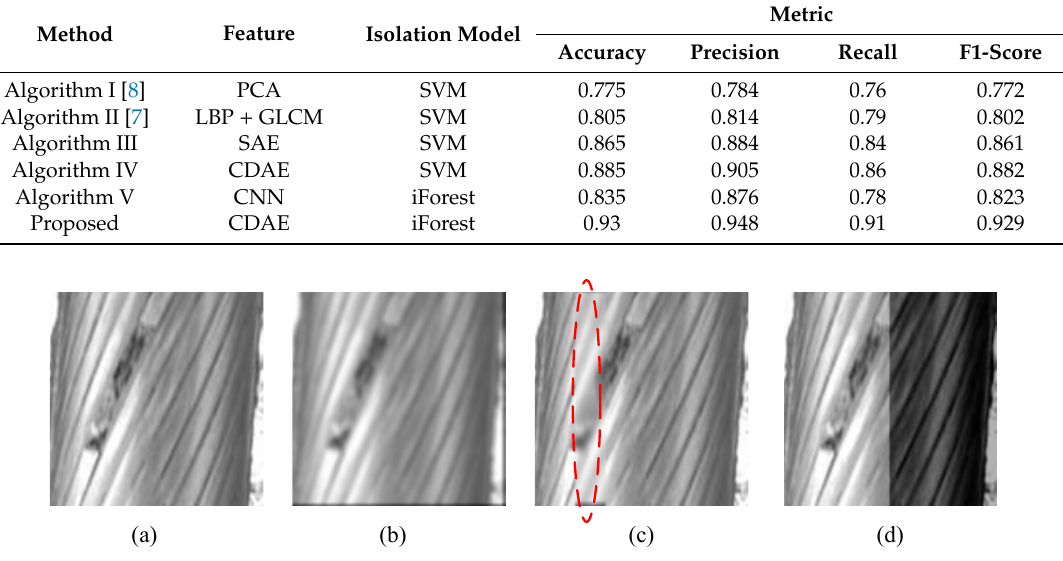
Figure 5. Flaw image augmentation. ( a ) Source images; ( b – d ) Image augmentation by applying Gaussian smoothing, reducing local contrast, and adding shadow, respectively. Table 2. Temperature and wildlife count in the three areas covered by the study. LBP: local binary patterns; GLCM: gray-level co-occurrence matrix; CDAE: convolutional denoising autoencoder; CNN: convolutional neural network.